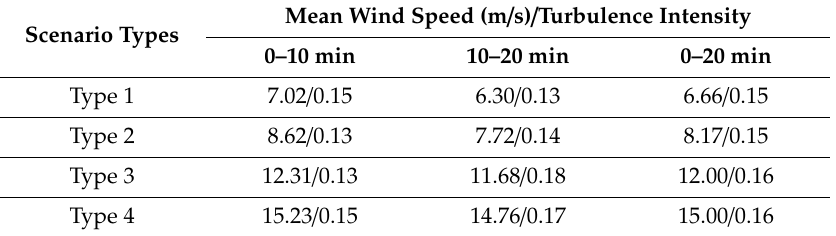
Figure 6. Wind scenarios. Table 2. Characteristic parameters of wind scenarios. Table 2. Characteristic parameters of wind scenarios.